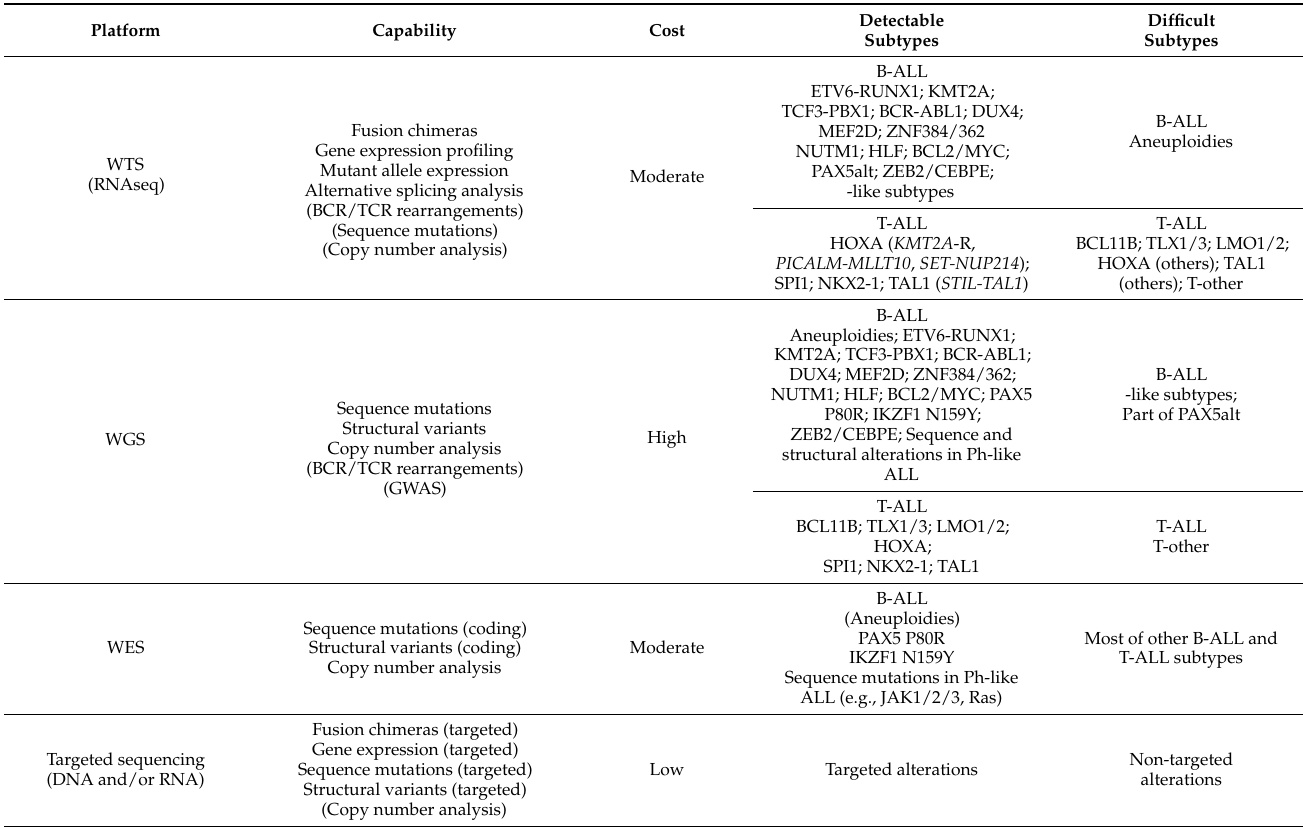
The parenthesis in “Capability” indicates analyses in development. Abbreviations: WTS: whole transcriptome sequencing; BCR: B-cell receptor; TCR: T-cell receptor; WGS: whole genome sequencing; GWAS: genome wide association study; WES: whole exome sequencing; -R: